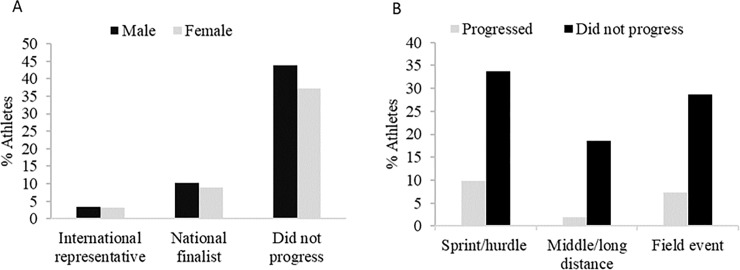
The percentage of junior finalist by genders (A) and by athletic events (B) who progressed and who did not progress to senior levels of competition.